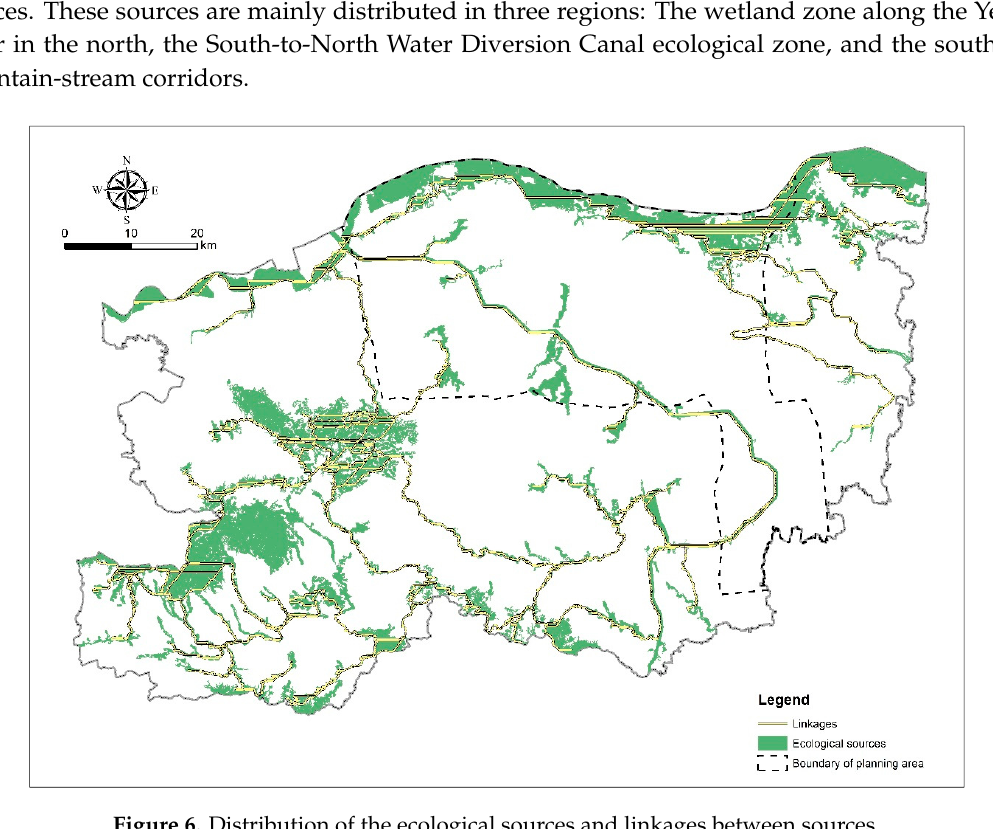
Figure 6. Distribution of the ecological sources and linkages between sources.